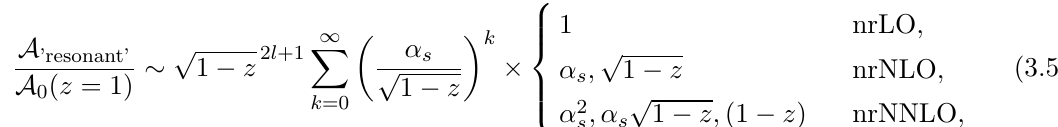
Figure 6 . Matrix element at leading order in the power counting (cid:11) s (cid:24)